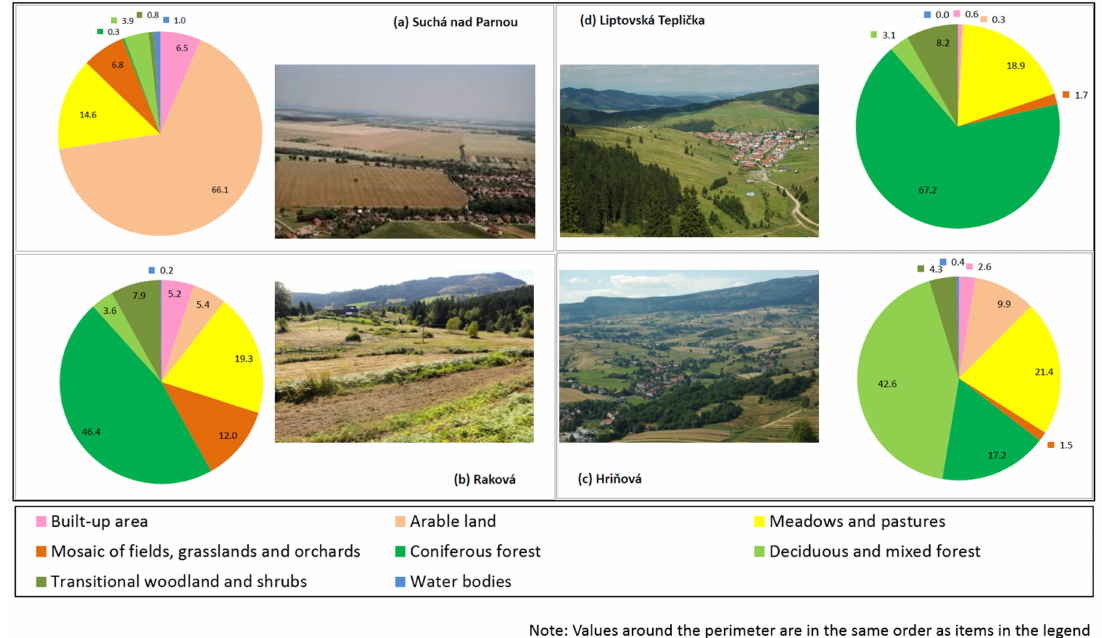
Figure 2. Land cover in the four selected study areas (in %). ( a ) Suchá nad Parnou, ( b ) Raková, ( c ) Hri ň ová, ( d ) LiptovskáTepli č ka.